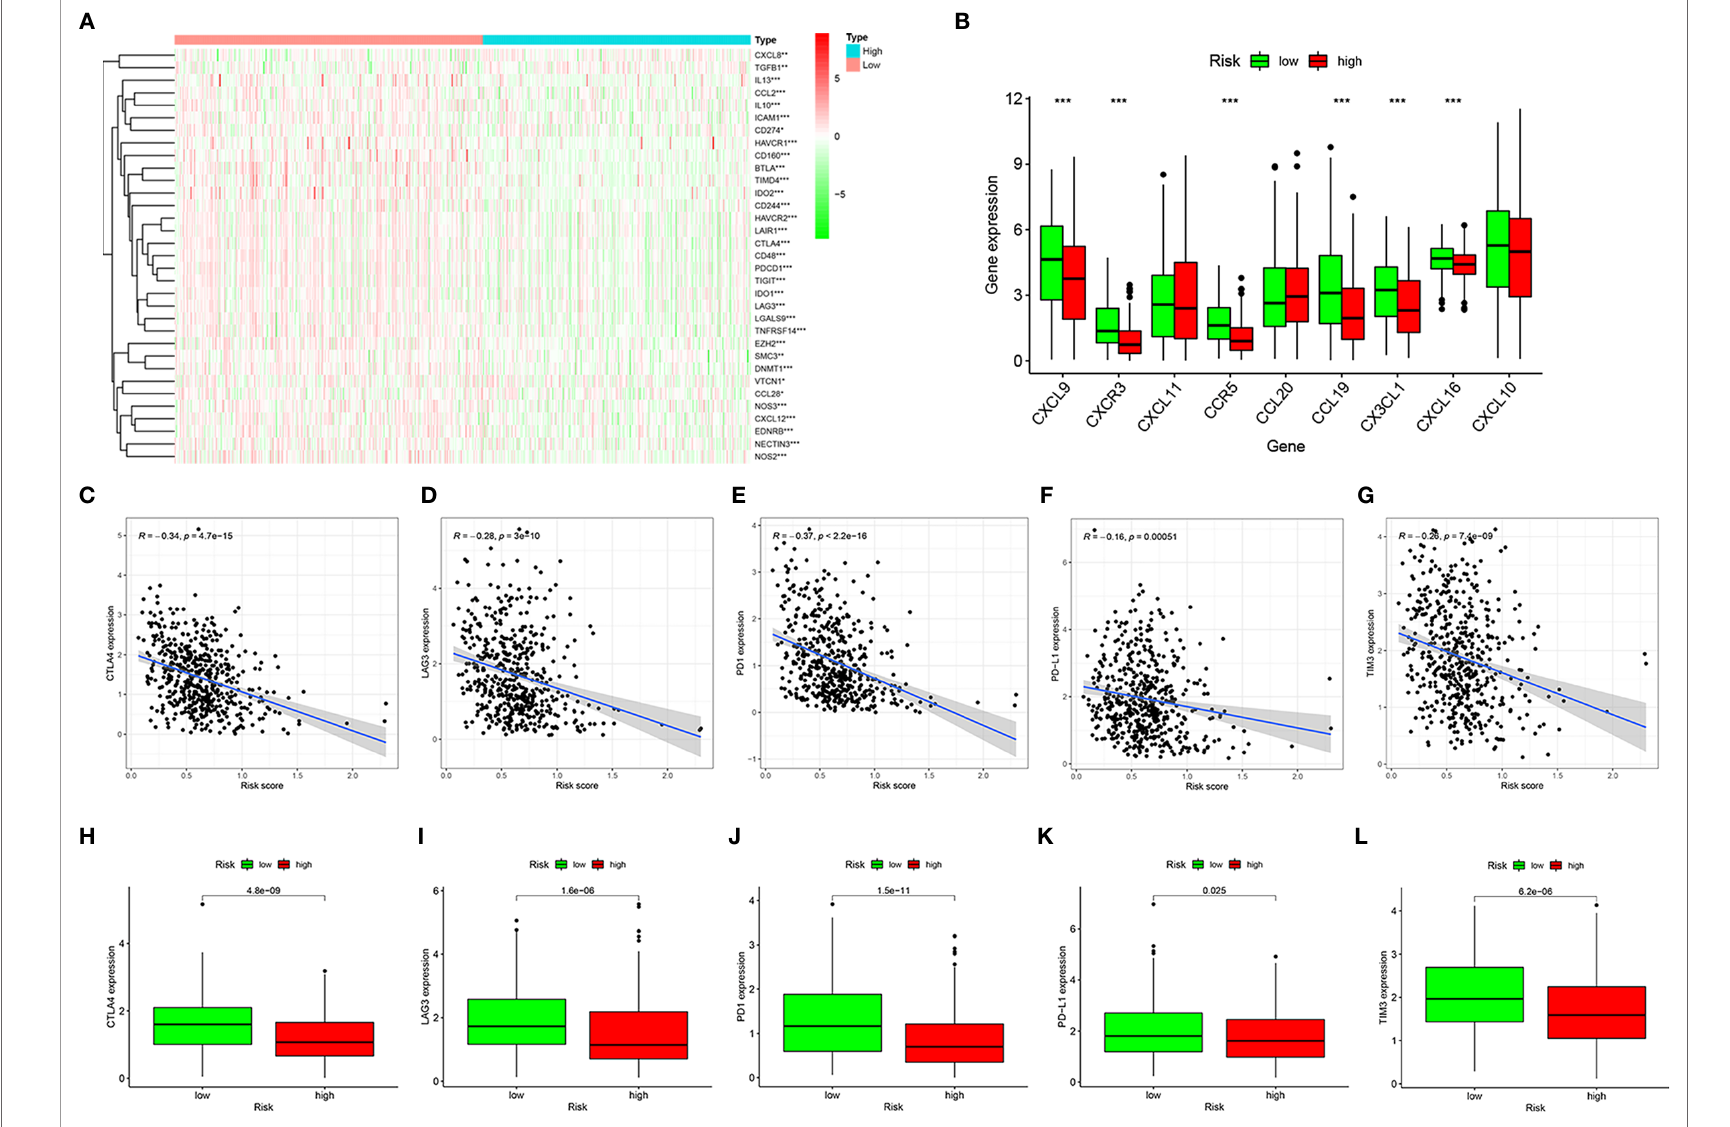
FIGURE 6 | Estimation of immune regulatory gene expression. Heatmap of negative immune regulatory gene expression (A) . Differential expression of CD4+ T cell and CD8+ T cell regulatory genes in the high- and low-risk groups (B) . Correlation between gene expression and risk scores of CTLA4 (C) , LAG3 (D) , PD1 (E) , PD-L1 (F) , and TIM3 (G) . Differential expression of CTLA4 (H) , LAG3 (I) , PD1 (J) , PD-L1 (K) , and TIM3 (L) genes in high- and low-risk groups. * P < 0.05, ** P < 0.01, *** P <